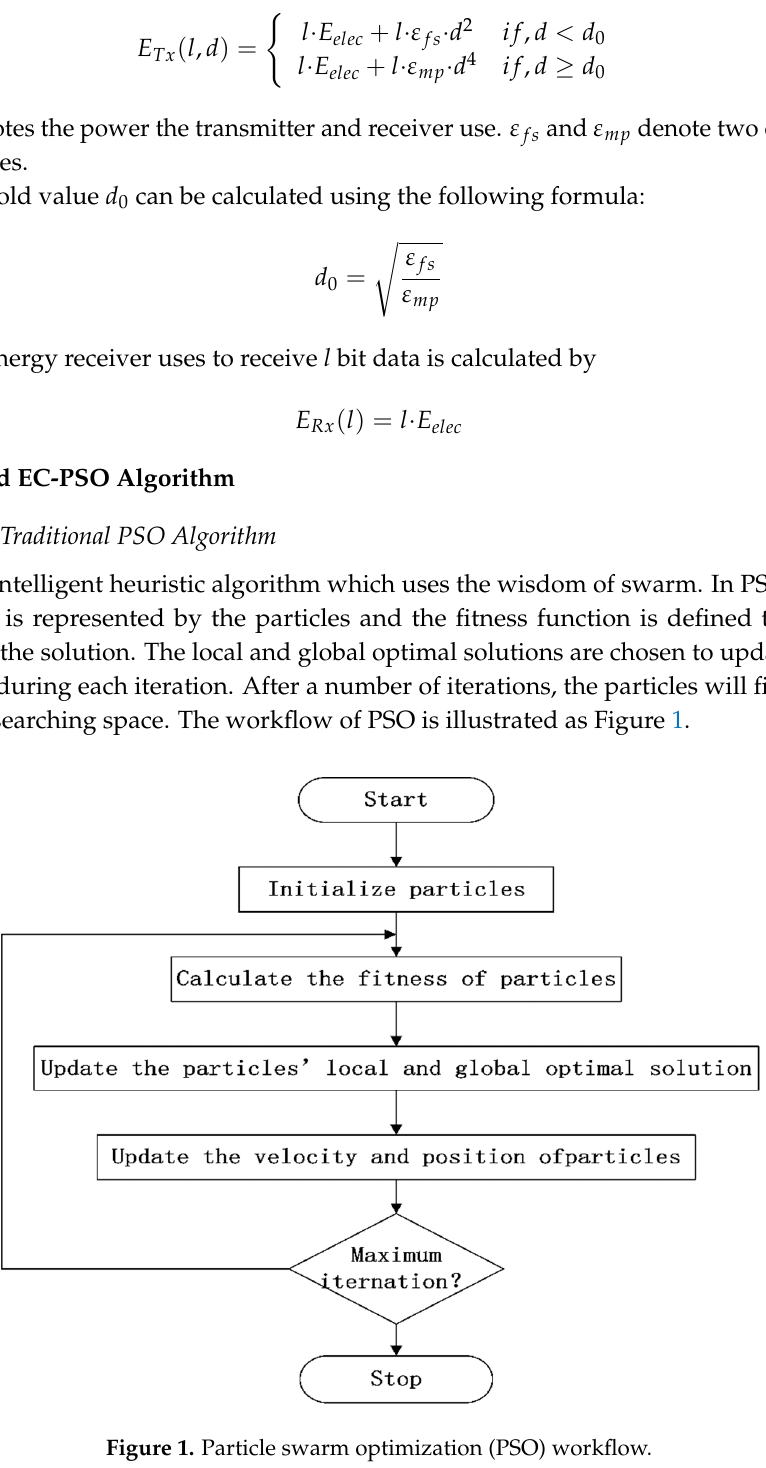
Figure 1. Particle swarm optimization (PSO) workflow.